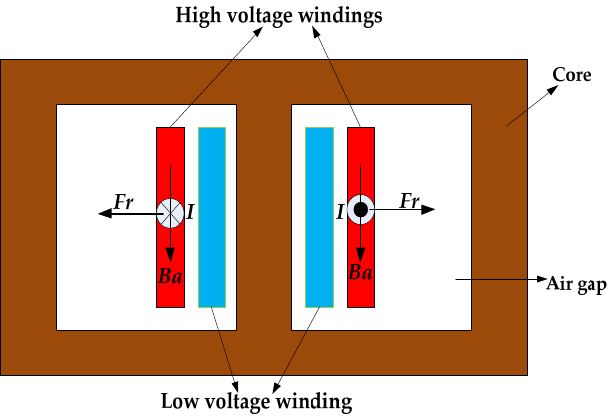
Figure 4. The radial force generated on the winding under the inrush current.